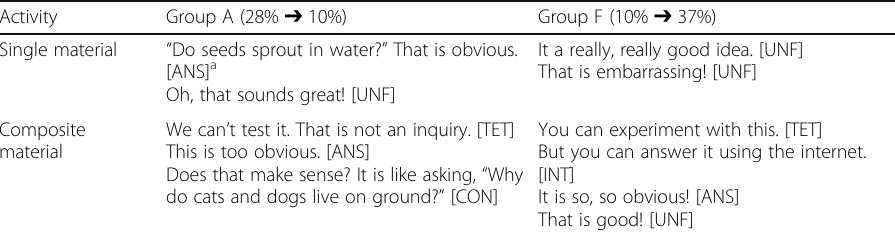
Table 5 Evaluation utterance patterns exemplified in groups A and F Activity Single